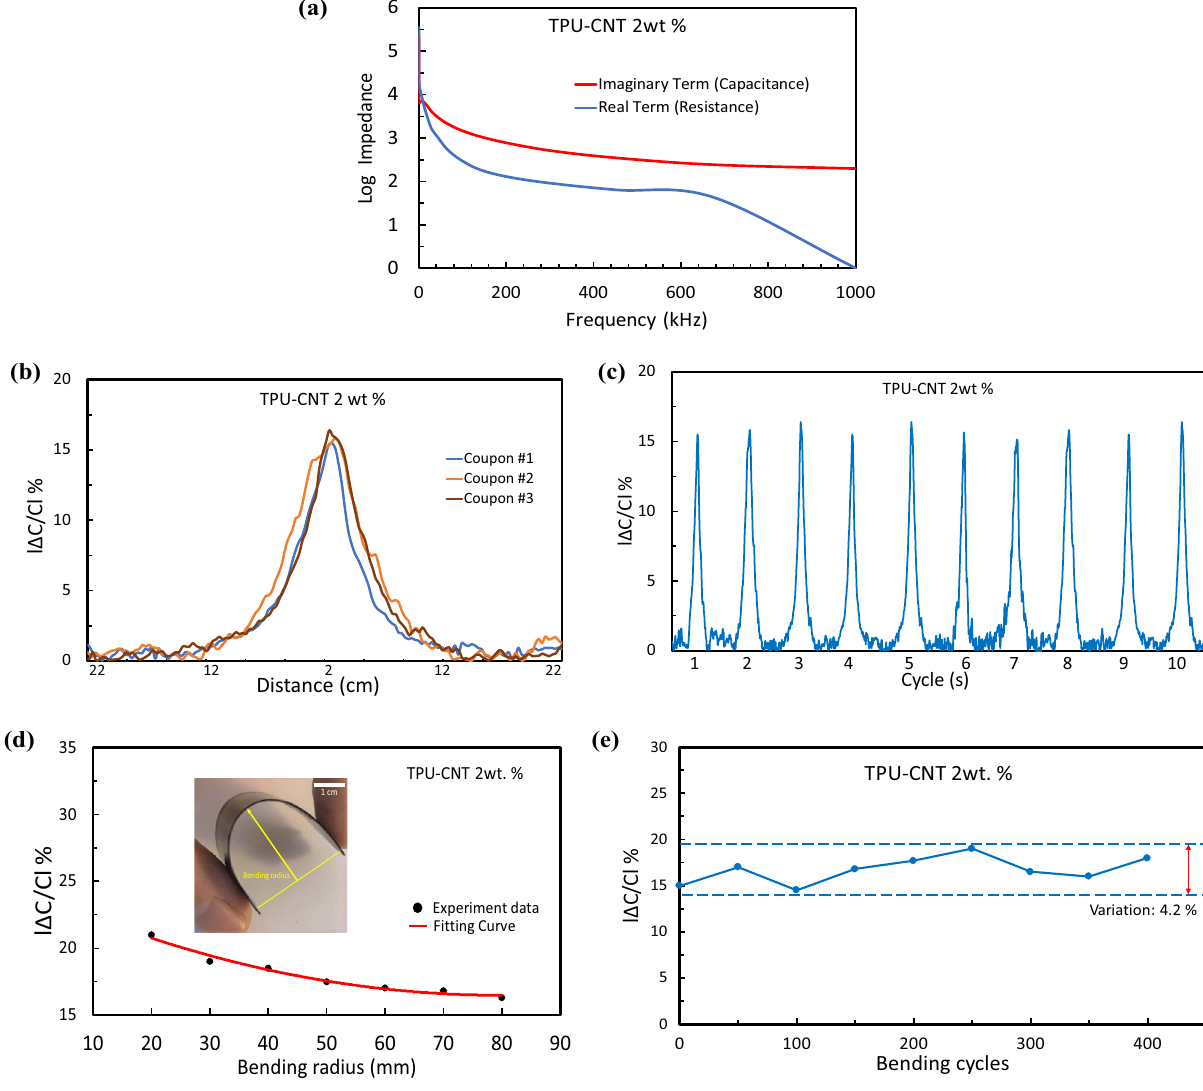
Figure 4. Sensor characterization with 2 wt%. CNT ( a ) Nyquist stability plot of the impedance sensing to the magnetic field at different exciting frequencies. From EIS, the stable region of frequency response for imaginary and real are initiated around 500 kHz. ( b ) Reproducibility response of sensors for three different coupons of similar manufacturing process. ( c ) Repeatability response with several identical approaching cycles along with repeatable peaks. ( d ) Relative change in capacitance of the sensor film under various bending radii of 20–80 mm. ( e ) Mechanical flexibility of the tactile sensor—relative change in capacitance measured for 400 bending/relaxing cycles at a bending radius of 20